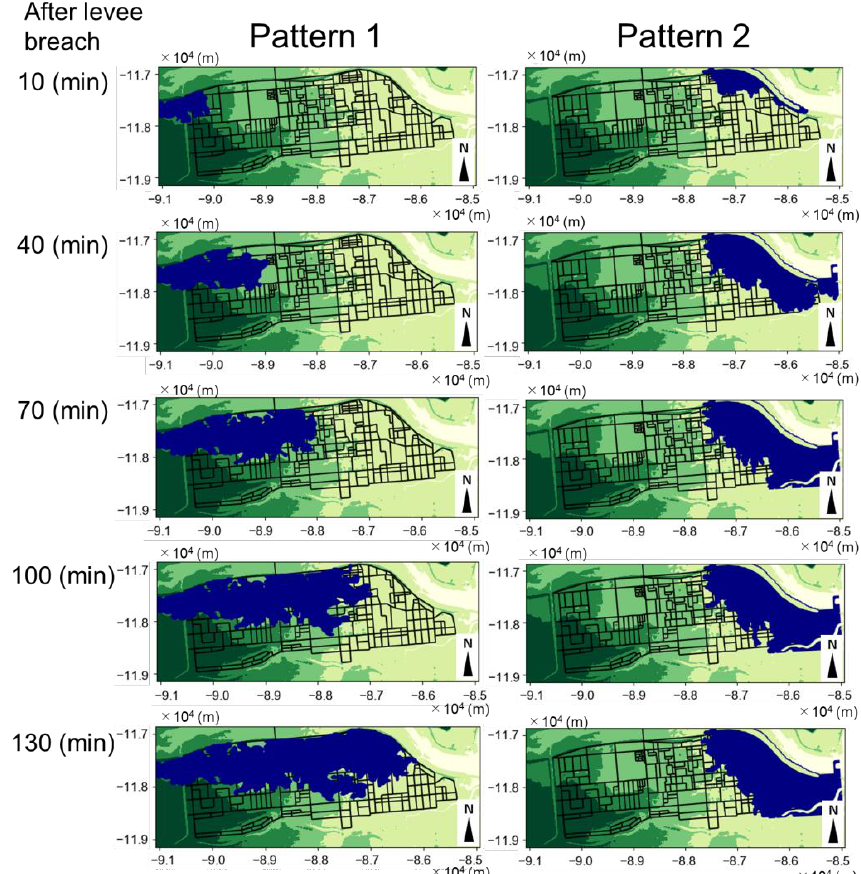
Figure 4. The results of flood simulations. Pattern 1 is the result of a levee breach upstream of the study site. Pattern 2 is the result of a levee breach downstream of the study site. Blue indicates the flooded area.